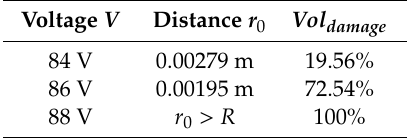
Table 4. The irreversible thermal damage of lipoma tumor at t = 210s.